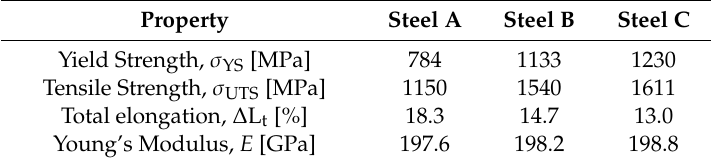
Table 2. Monotonic mechanical properties of the tested steels (Data from [6,9]). Property